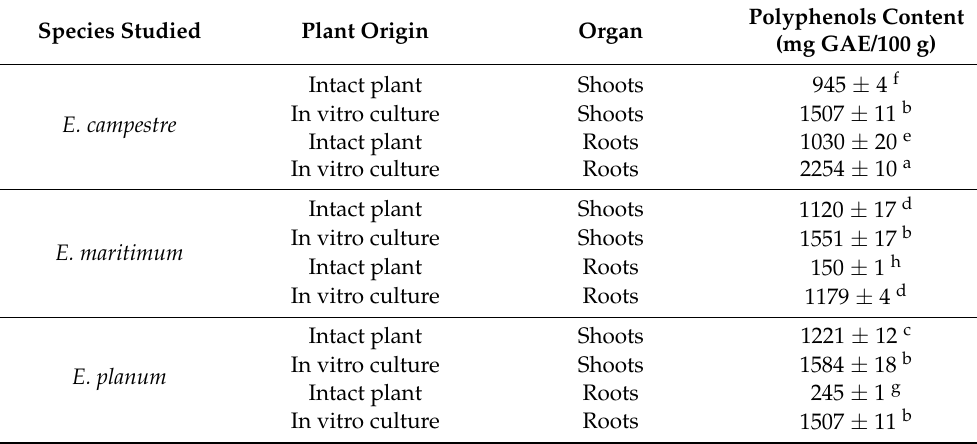
Table 4. Total phenolic content in Eryngium species dry plant material evaluated by Folin–Ciocalteau method, expressed as gallic acid equivalent (mg/100 g). Species Studied Plant Origin Organ